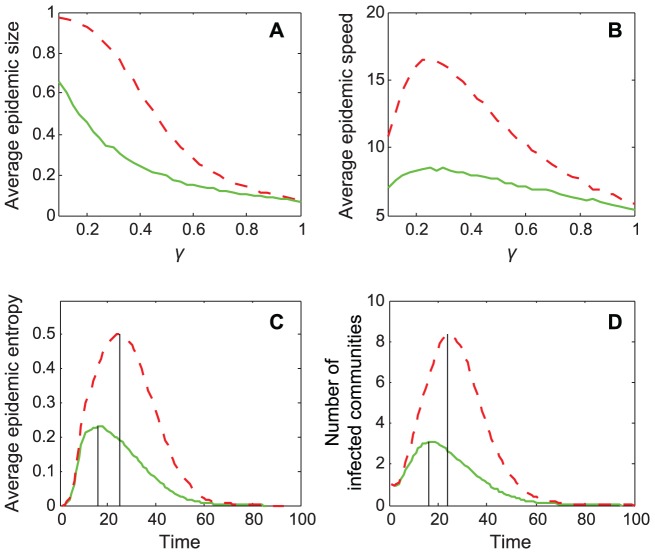
Comparison of Epidemic properties in sparse-strong and dense-weak styles of weighted community networks.(A) average epidemic size (i.e., density of infected nodes) as a function of recovery rate γ; (B) average epidemic speed (i.e. the ratio of total infected nodes to total epidemic steps) as a function of recovery rate γ; (C) average value of the epidemic entropy as a function of time steps; and (D) average number of infected communities (it has at least one infected node at a time) as a function of time steps. The network parameters are: N = 20, M = 50, dI = 4, dE = 0.04 or 1, v = 0.5 and w = 0.49 or 0.02. The modularity Q = 0.94 for both mixing styles. The recovery rate γ = 0.35 in (C) and (D). Solid curves represent sparse-strong style networks and dashed curves represent dense-weak style networks. The vertical lines indicate the appearing time of maximal value of average epidemic entropy and number of infected communities in C and D.